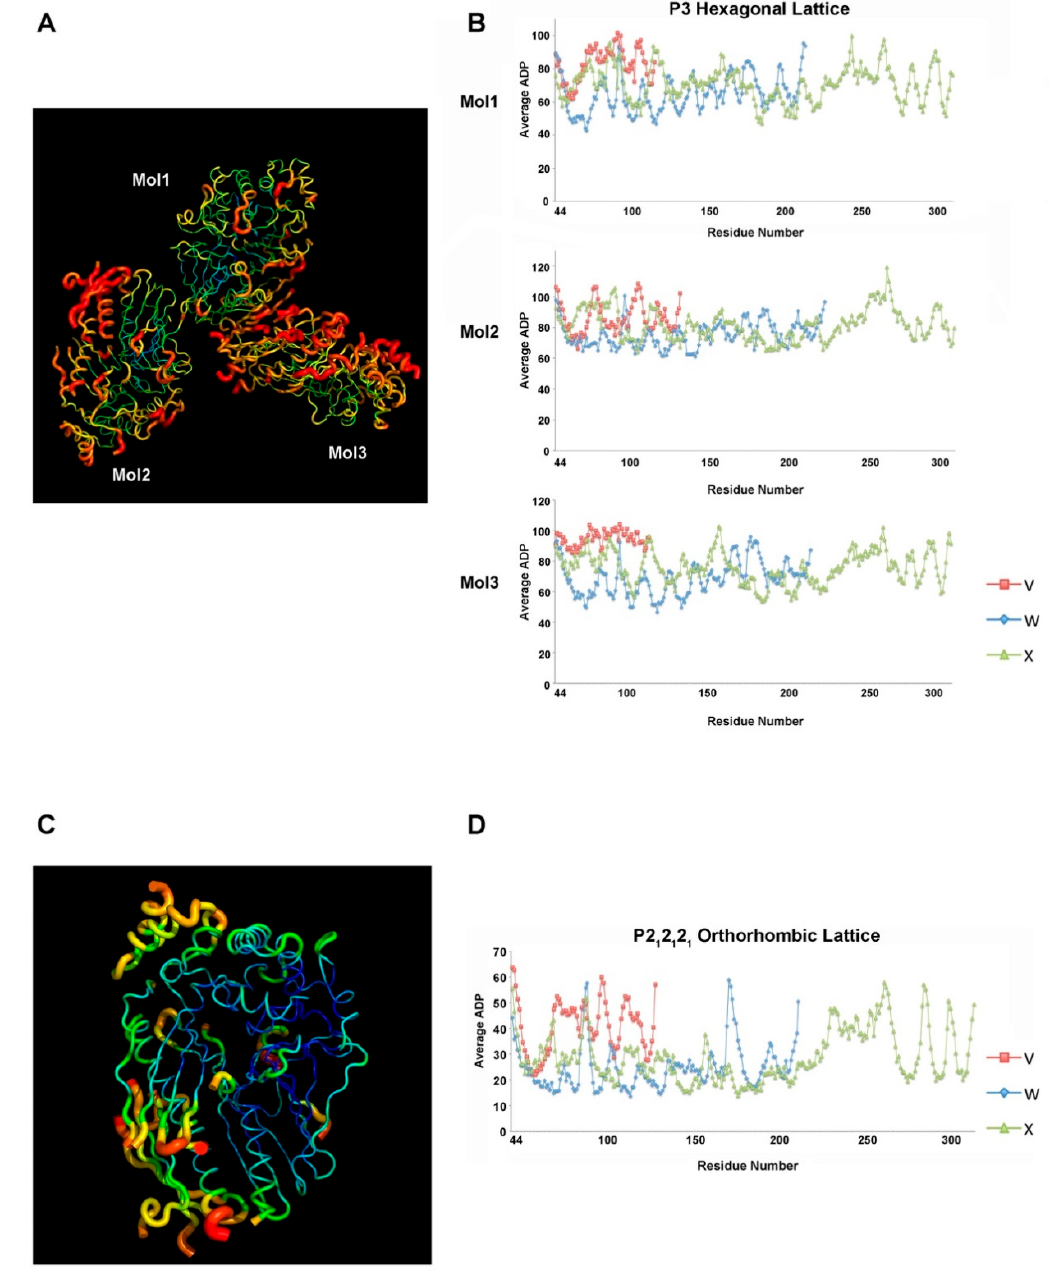
Figure 5. Atomic displacement parameters of the XcpVWX complex in the two types of Bravais lattices. ( A , B ) atom displacement parameter (ADP) distribution schematic and ADP values of the protein residues in the hexagonal lattice. ( C , D ) ADP distribution schematic and ADP values of protein residues in the orthorhombic lattice.